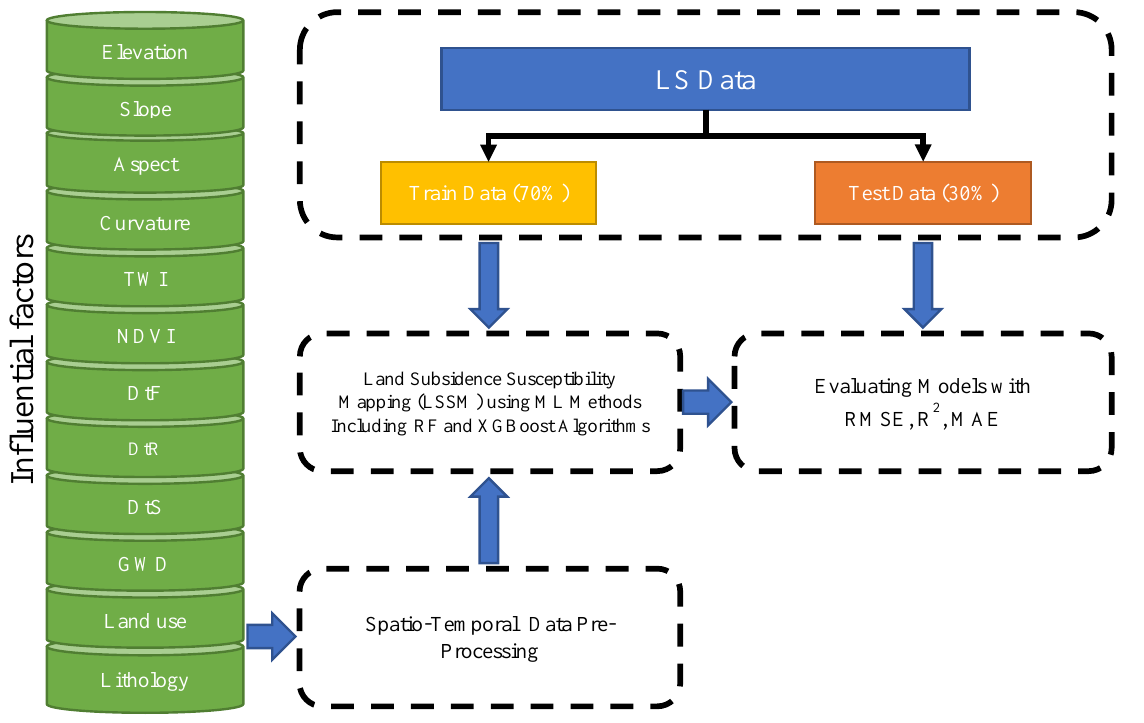
Figure 2. Flowchart of research methodology.